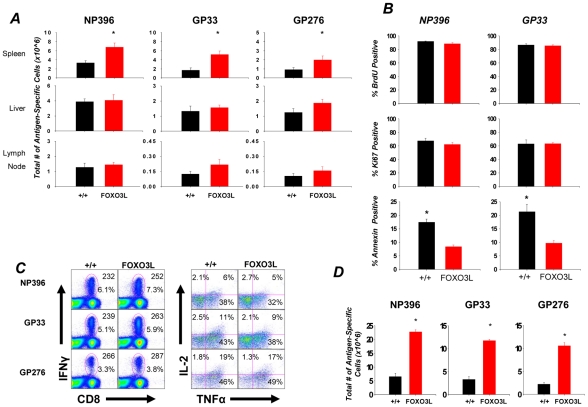
FOXO3 regulates CD8 T cell expansion through T cell-intrinsic mechanisms.(A) +/+ and FOXO3L mice were infected with LCMV. At 8 days PI, mononuclear cells from spleen, liver and lymph nodes were stained with anti-CD8 and MHC-I tetramers. Data are from 3–4 independent experiments with 4–6 mice/group/experiment; error bars represent the SEM and * indicates statistical significance at p<.03. (B) Investigation of in vivo proliferation and apoptosis by BrdU incorporation/Ki67 staining and Annexin V staining. +/+ and FOXO3L mice were infected with LCMV and given a BrdU injection at 6 days PI and administered BrdU in drinking water between days 6–8 PI. At the end of the BrdU pulse, splenocytes were stained with anti-CD8, MHC-I tetramers and anti-BrdU. The percentage of BrdU positive cells amongst tetramer positive CD8 T cells was determined by flow cytometry (top panel). In parallel studies, mononuclear cells were stained with anti-CD8, MHC-I tetramer and anti-Ki67 (middle panel) or Annexin V (lower panel). The percentage of Ki67 or Annexin V positive cells amongst tetramer positive CD8 T cells was determined by flow cytometry. Data are from 2–3 independent experiments; Graphs represent data from 6–8 mice/group/experiment; error bars represent the SEM and * indicates statistical significance at p<.001. (C) At day 8 PI, splenocytes were stimulated in vitro with LCMV specific peptides for 5 hours. Following stimulation, cells were stained for surface expression of CD8 and intracellular expression of IFNγ, IL-2 and TNFα. Representative dot plots (left) are gated from total lymphocytes with the top numbers indicating the MFI for IFNγ on CD8 T cells while the bottom number in the plot indicates the percentage of total splenocytes that are CD8 and IFNγ positive. Dot plots (right) represent the percentages of IL-2 and/or TNFα producing cells among IFNγ+ve CD8 T cells. Representative plots from 1 of 6 individual experiments are illustrated. (D) To deplete CD4 T cells, +/+ and FOXO3L mice were injected with 100 ug of the monoclonal antibody, GK1.5, at days 0 and 4 relative to LCMV infection. At day 8 PI, splenocytes were stained with anti-CD8 and MHC-I tetramers to determine the total number of LCMV-specific CD8 T cells. Bars represent data collected from at least 4 mice; error bars represent the SEM and * indicates statistical significance at p<.01.